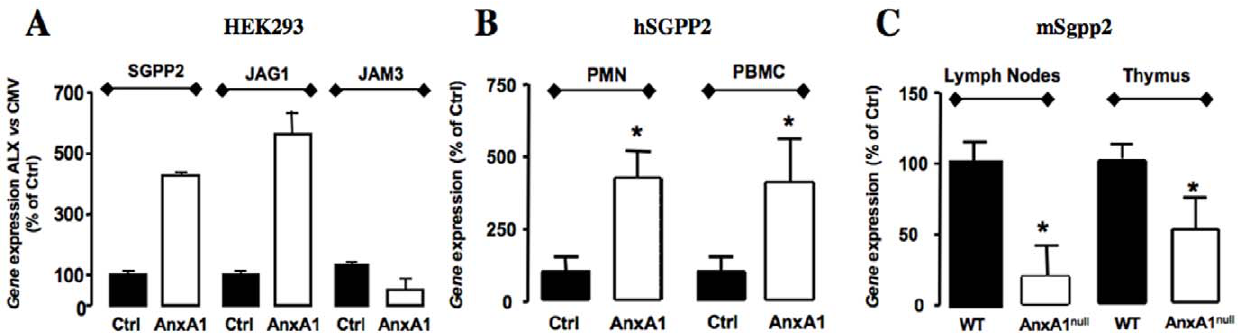
Figure 5. Real time-PCR validation. A) Gene expression of SGPP2, JAG1 and JAM3 in ALX-HEK293 transfected cells compared to empty vector- transfected cells (CMV group). B) Gene expression of SGPP2 in human peripheral mononuclear cells (PBMC) and polymorphonuclear cells (PMN), under control conditions (Ctrl) or after 4 h incubation with 0.5 m M AnxA1 (AnxA1). C) mSGPP2 gene expression in lymph nodes and thymuses of wild type (WT) and AnxA1 null mice. (* p , 0.05, t-Test compared to controls (A,B) or wild type